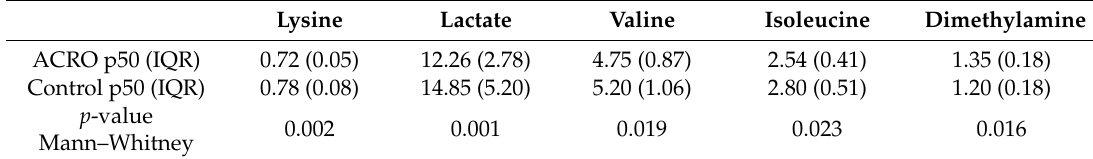
Table 3. Arbitrary units of the main metabolites that di ff erentiate the case and control groups. Lysine Lactate Valine